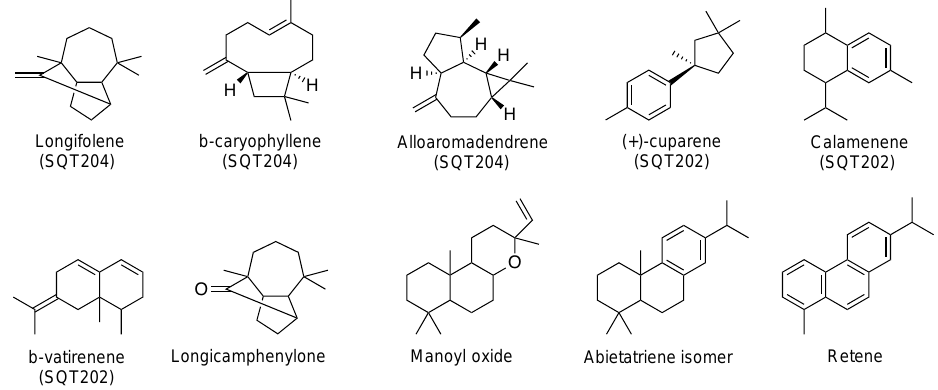
Figure 3. Sample terpenoids observed during BEACHON-RoMBAS.